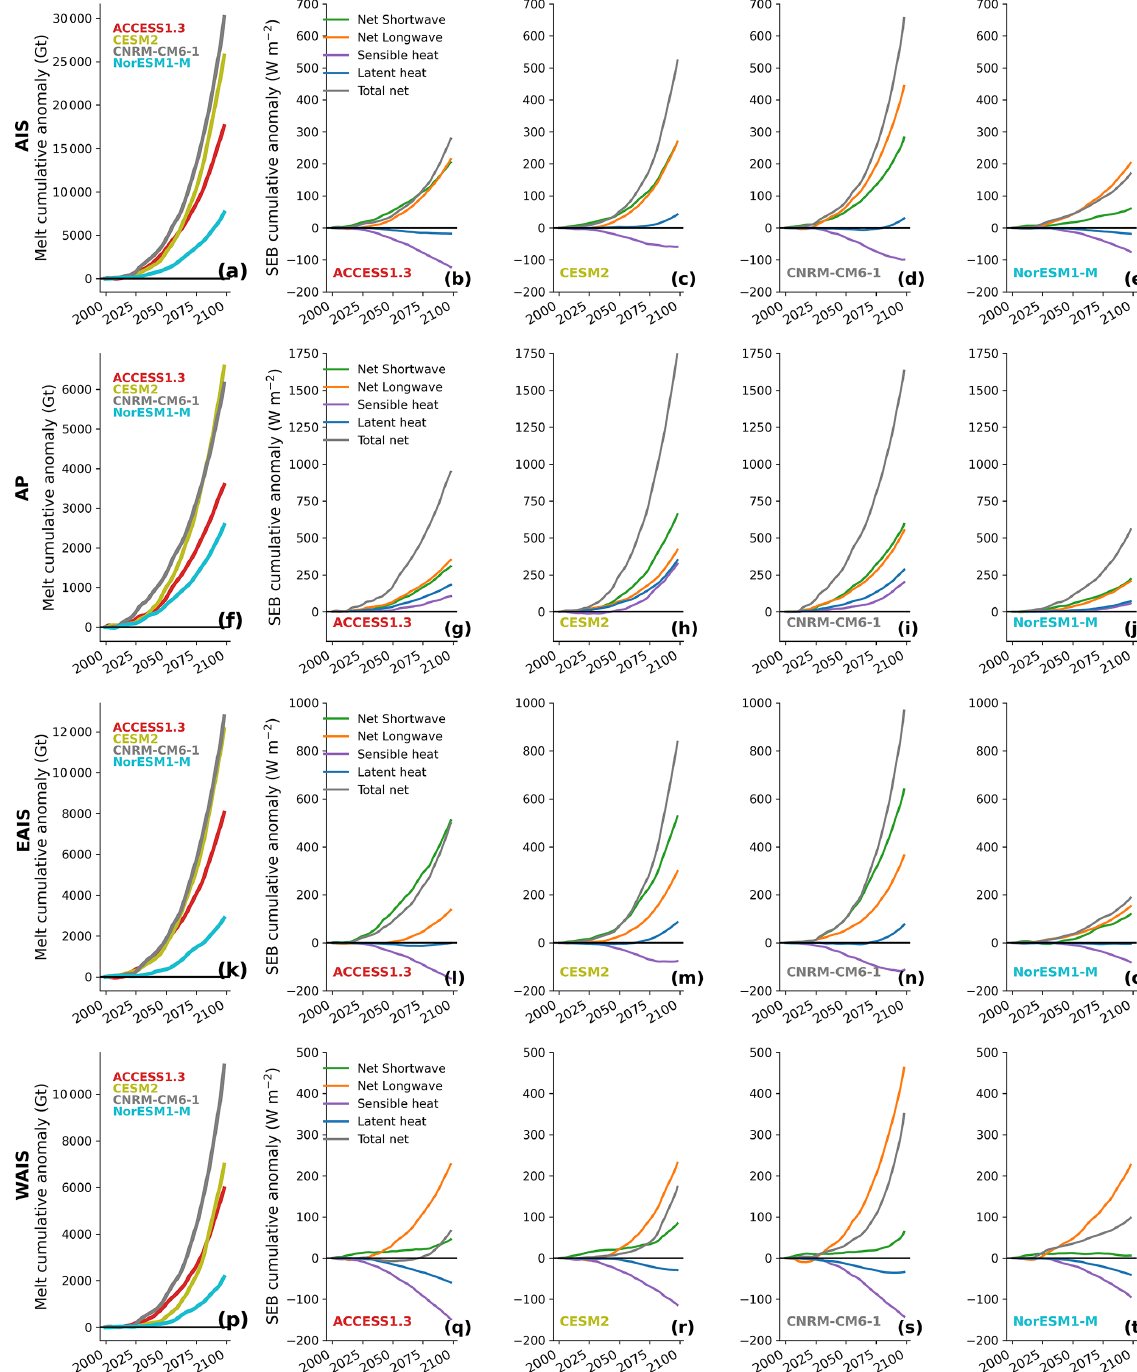
Figure 1. Cumulative surface melt (Gt) and SEB changes (Wm − 2 ) over the Antarctic ice shelves. The first row (a–e) shows the cumulative integrated surface melt and averaged SEB components over the whole Antarctic ice shelves, while the second row (f, g, h, i, j) is for the Antarctic Peninsula; the third row for the East Antarctic sector (k, l, m, n, o) ; and the fourth row (p, q, r, s, t) for the West Antarctic sector, including Ross and Ronne–Filchner ice shelves. The second to the fifth columns represent the cumulative changes for each SEB component (green: net shortwave; orange: net longwave; purple: sensible heat; blue: latent heat) for each MAR simulation (the second row: forced by ACCESS1.3; the third row: CESM2; the fourth row: CNRM-CM6-1; the fifth row: NorESM1-M).